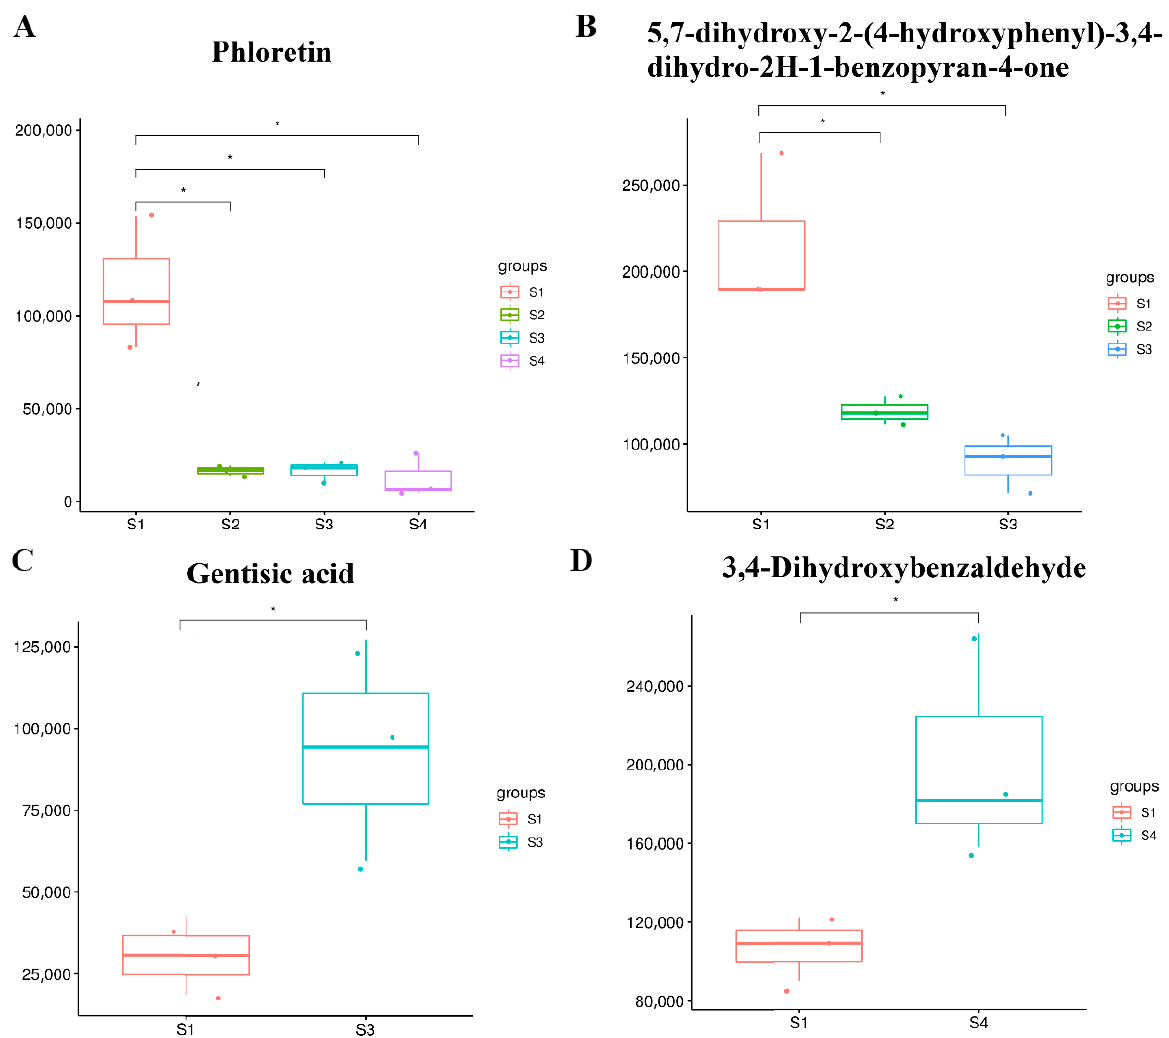
Figure 6. Box-and-whisker plots of differential metabolites related to flavonoids. ( A ) Phloretin; ( B ) 5,7-dihydroxy-2-(4-hydroxyphenyl)-3,4-dihydro-2H-1-benzopyran-4-one; ( C ) Gentisic acid; ( D ) 3,4- Dihydroxybenzaldehyde. * represented signifificance at level 0.05.